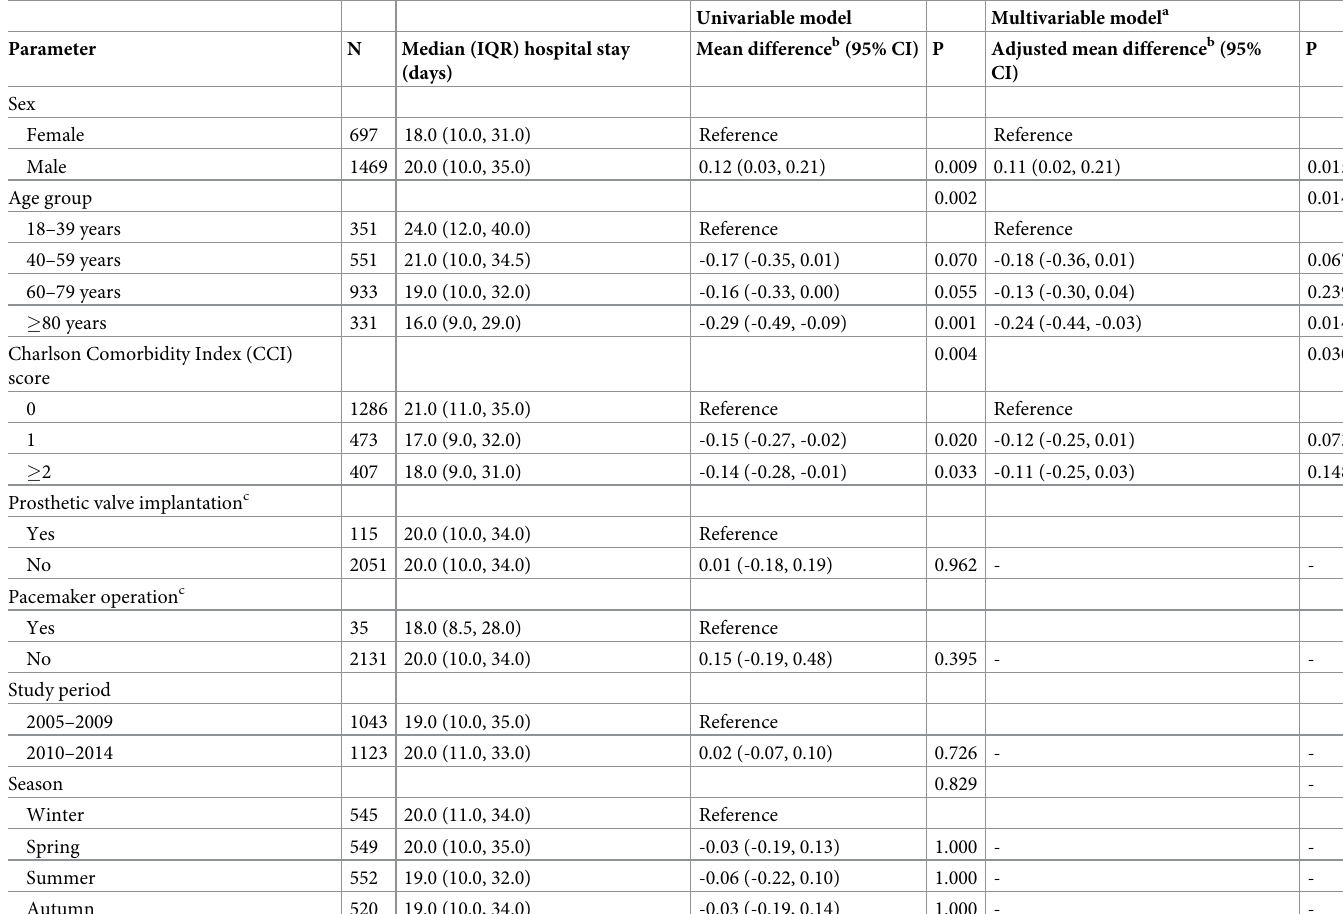
Table 1. Predictors of length of stay in patients with infective endocarditis admission during 2005–2014 in Finland (n =